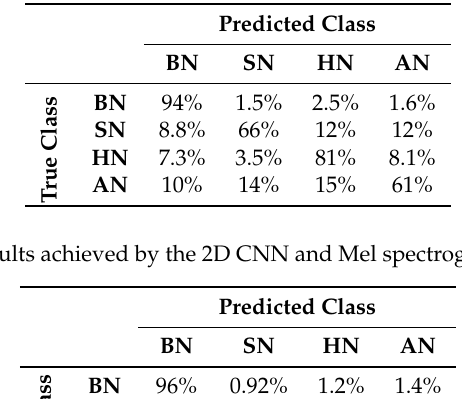
Table 6. Results achieved by the 2D CNN and MFCCs as input.